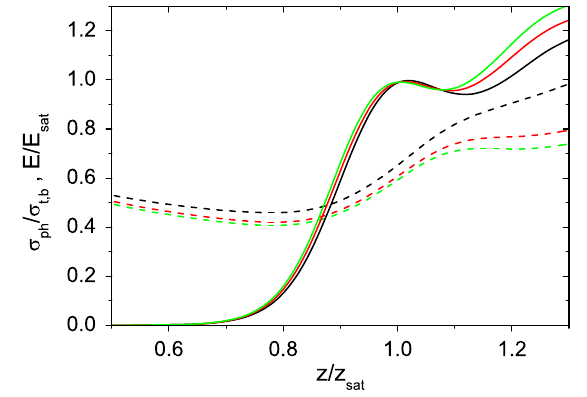
FIG. 2. The evolution of the energy in the radiation pulse E (solid line) and rms photon pulse duration σ (dashed line) are ph shown as functions of the undulator length. The three color codes (black, red, and green) refer to different values of the electron ¼ 2 , 4, and 8. The values are normalized pulse duration ρωσ t;b = σ as E=E and σ . For the presented experiments, ρωσ was t;b t;b sat ph about